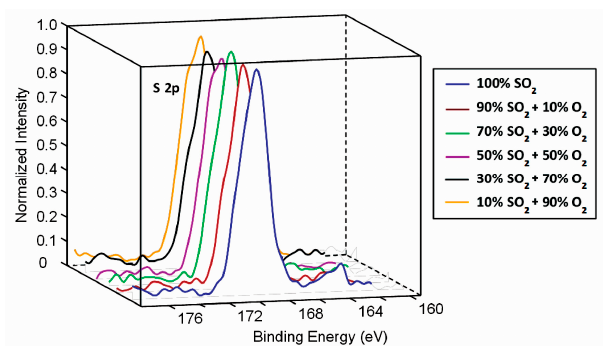
Figure 6. High-resolution S2p peak for samples treated at various SO 2 + O 2 mixtures.